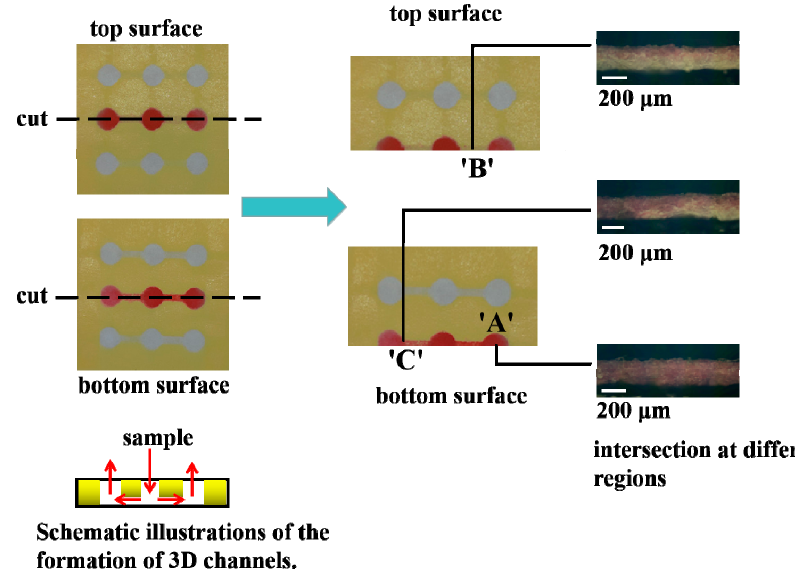
Figure 4. The intersection of the 3D sl- μ PADs captured under an optical microscope.